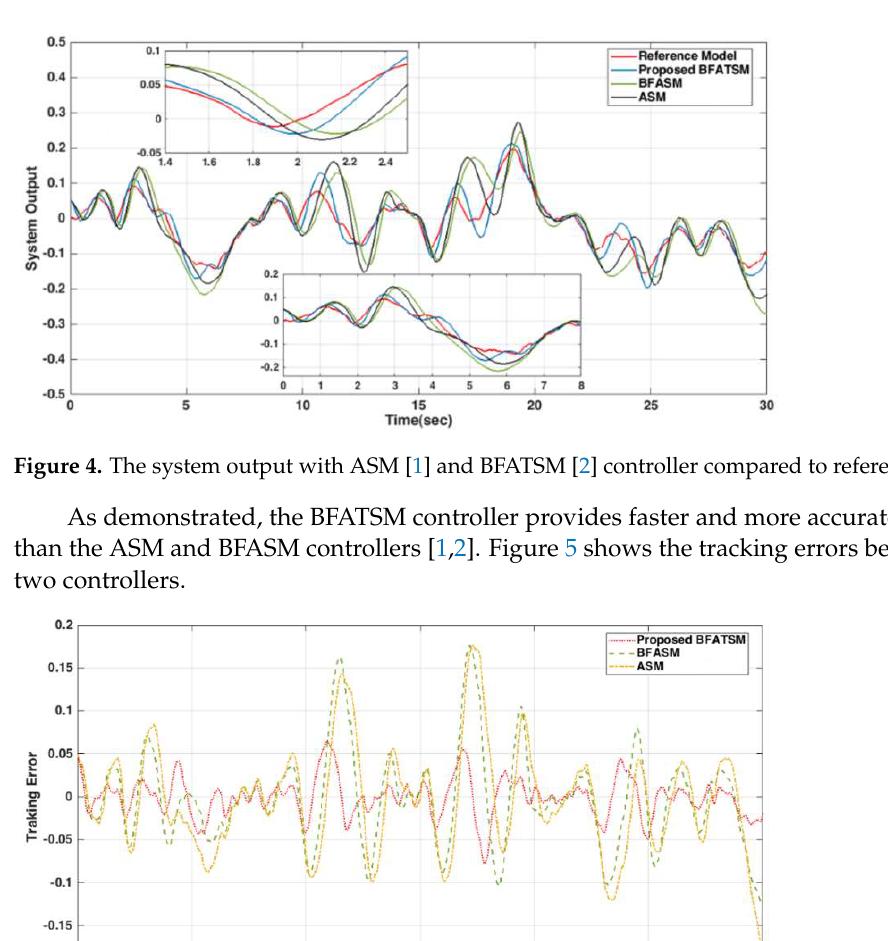
Figure 5. Tracking errors between ASM [1] and BFATSM [2] controllers.